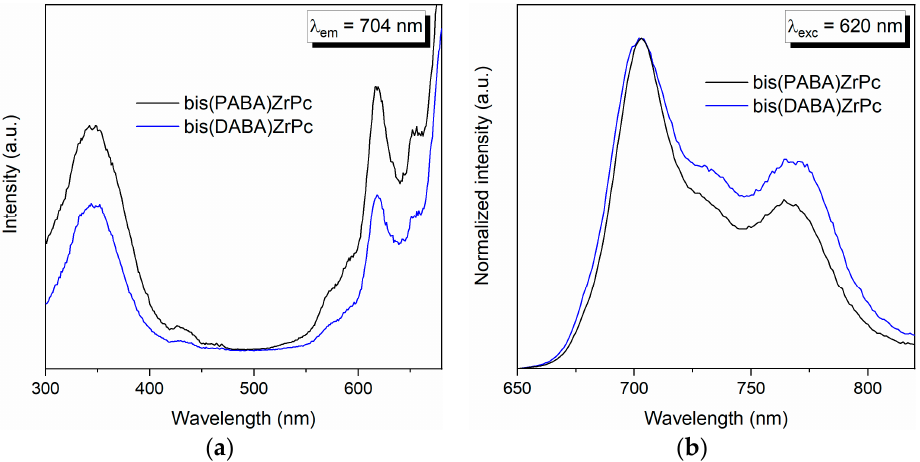
Figure 9. ( a ) Photoluminescence excitation ( λ em = 704 nm) and ( b ) photoluminescence spectra ( λ exc = 620 nm) of bis (PABA) ZrPc and bis (DABA) ZrPc in DMSO.